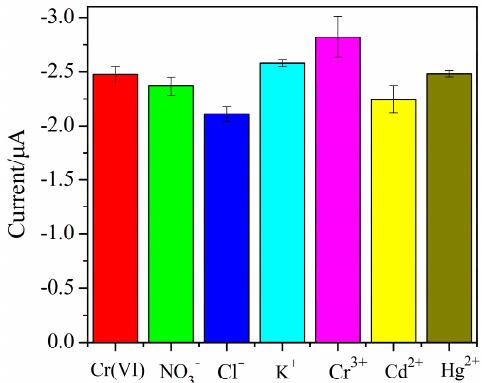
Figure 14. The influence of foreign ions on the current response of Cr (VI) detection.